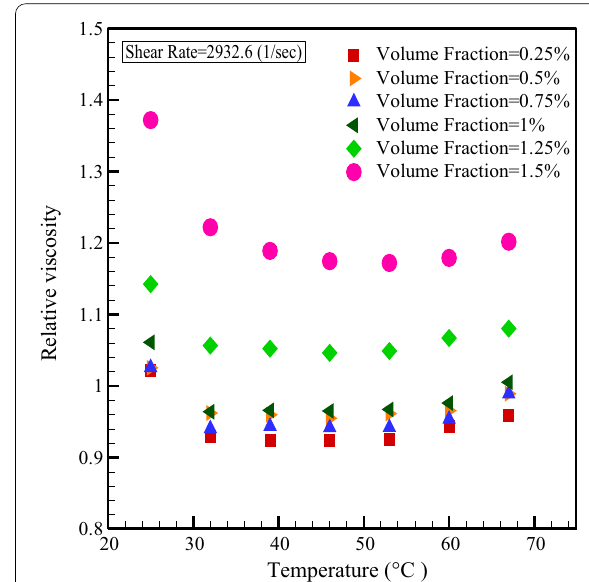
Fig. 11 Relative viscosity changes with temperature at constant SR